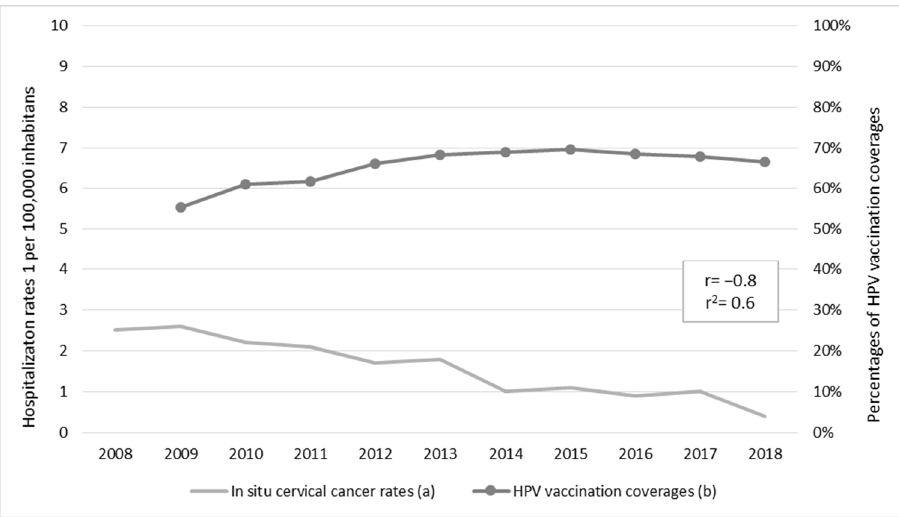
Figure 5. Correlation between hospitalization rates due to in situ cervical cancer and vaccination coverage against human papillomavirus (HPV), with their respective average annual percent change (AAPC): ( a ) 2008–2018 AAPC = −14.7%, 95% CI = −18.7, −10.5, p < 0.001; ( b ) 2009–2018 AAPC = 2.0%, 95% CI = 1.1, 2.9, p < 0.001.